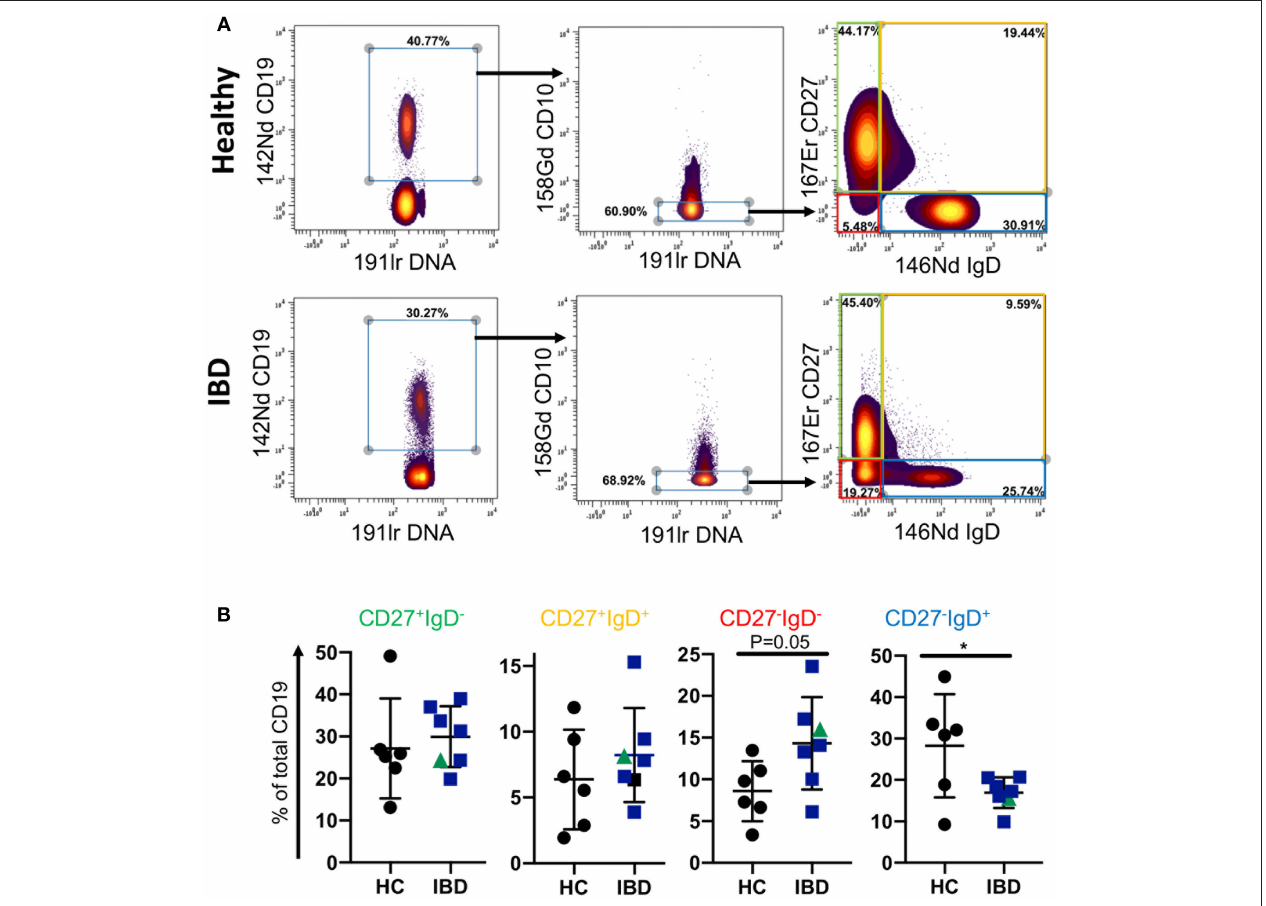
FIGURE 3 | B cell subsets in GALT of healthy control and IBD patients. Data was gated on the Cytobank platform. Following selection of CD19 + cells and elimination of CD10 + cells (since these would include germinal center cells in tissues and therefore not be equivalent to CD10 + subsets in blood), cells were gated according to their expression of CD27 and IgD. Examples of a HC and an IBD sample are illustrated in (A) . In (B) dotplots represent individually gated data points for HC ( n = 6), patients with UC ( n = 6 in blue) and a patient with CD in green, groups together as IBD. Groups were compared by Mann-Whitney U test where p < 0.05 =